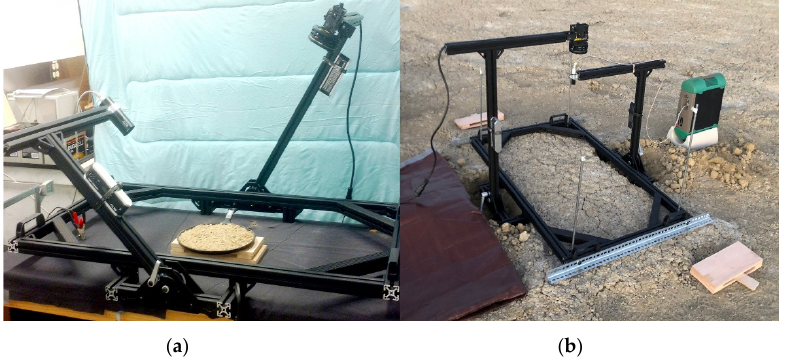
Figure 2. Goniometer platform constructed of 80–20 aluminum struts ready for ( a) laboratory or ( b ) field